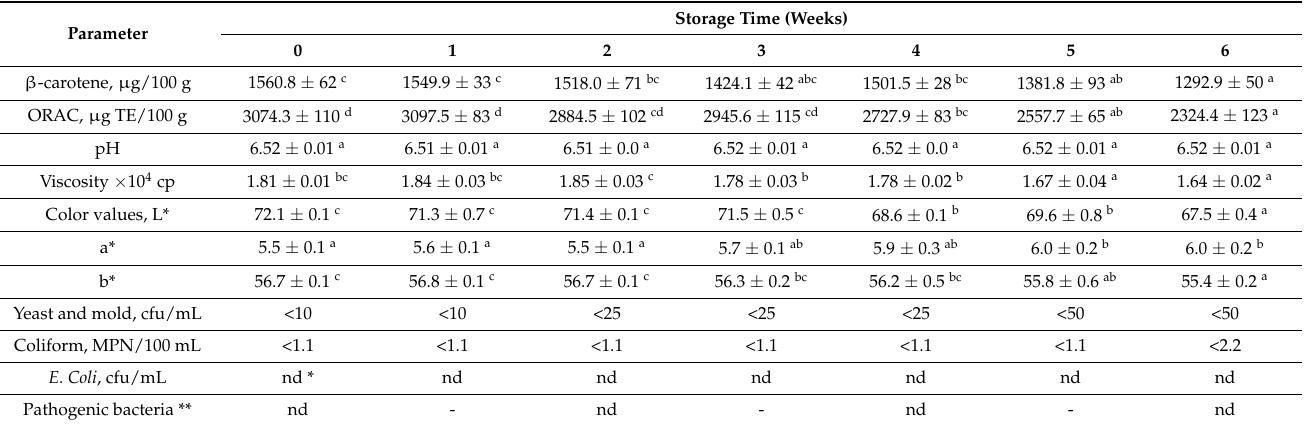
Table 4. Physicochemical quality and microbiological analyses of ready-to-eat soup product during storage at 5 ◦ C for 6